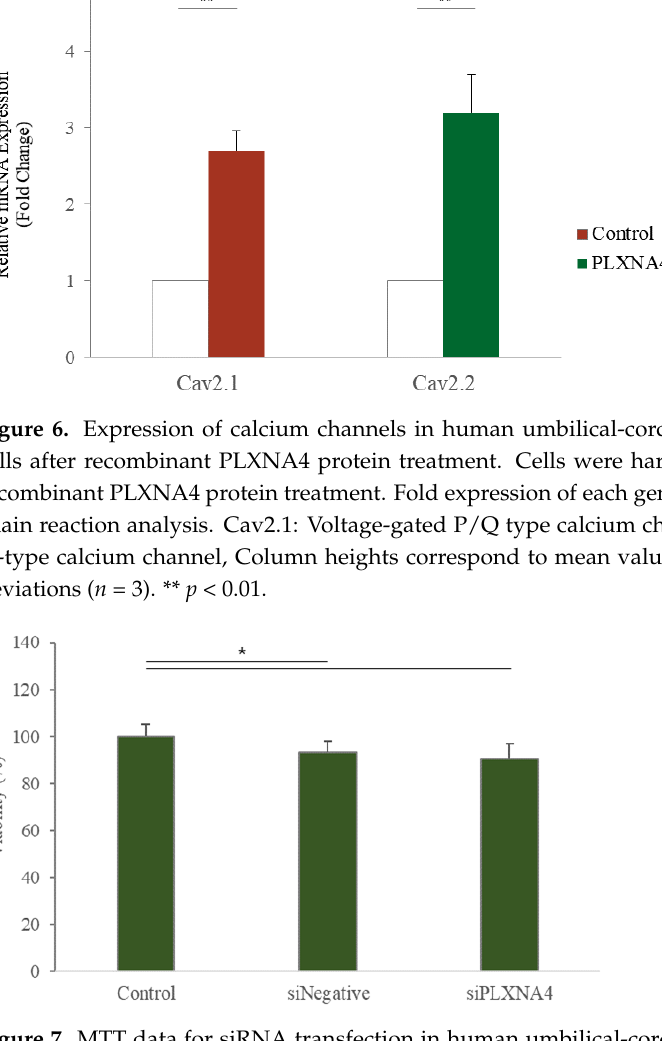
Figure 7. MTT data for siRNA transfection in human umbilical-cord-derived mesenchymal stem cells. Cells were harvested 2 days after siRNA duplex transfection. Column heights correspond to mean values and error bars to standard deviations ( n = 3). * p < 0.05.